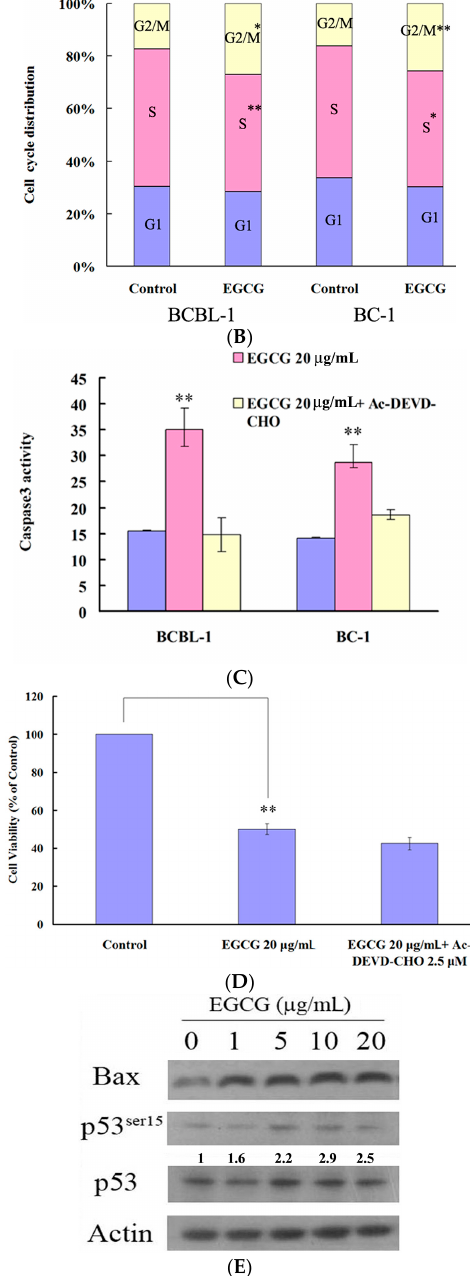
Figure 2. EGCG induces cell cycle arrest and apoptosis in PEL cells. ( A ) BCBL-1 and BC-1 cells were untreated or treated with 20 μ g/mL EGCG for 24 h. After treatment, PEL cells were incubated in methanol, treated with propidium iodide and subjected to cell cycle analysis using a Becton Dickinson FACScan flow cytometer and ModFit software described in the Materials and Methods section. Results are shown as the percentage of the apoptotic cells (sub-G1) in the EGCG-treated PEL cells; ( B ) Cell cycle distribution of EGCG-treated PEL cells. Representative results of the actual cell cycle profile are shown; ( C ) EGCG induced caspase-3 activation in PEL cells; ( D ) Effects of caspase-3 inhibitor (Ac-DEVD-CHO) on the cell viability of EGCG-treated BCBL-1 cells. The values represent mean ± SE of three independent experiments and are presented as the percentage of the control; * p < 0.05 and ** p < 0.01 indicate significant differences between the control and EGCG-treated cells. ( E ) Western blot analysis to detect p53 activation and Bax expression in EGCG-treated BCBL-1 cells. The representative data are shown. The relative intensity of phosphor-p53 at Ser15/total p53 is shown under each